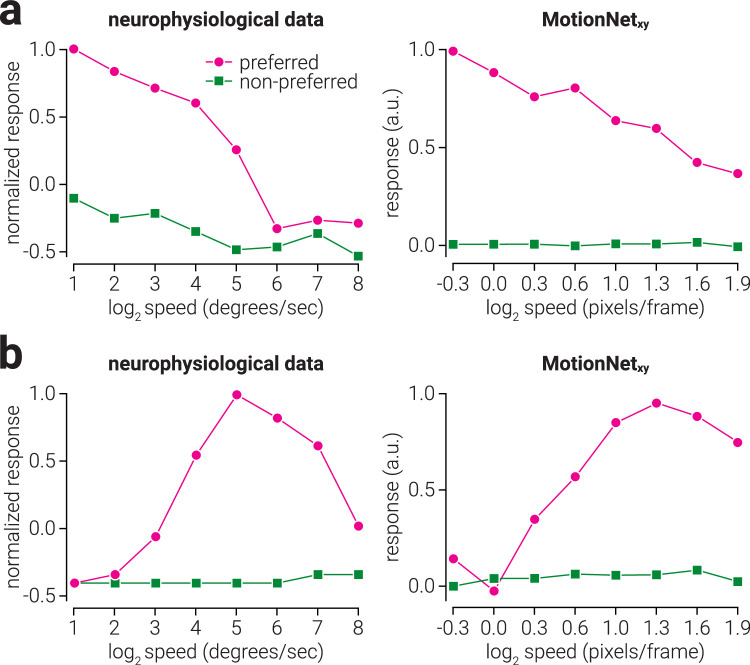
Biological and artificial visual system mechanisms of speed opponency. (a, b, left) Replotted data from Mikami, Newsome, and Wurtz (1986) showing the response of two MT neurons to a dot moving either in its preferred or non-preferred direction over a range of speeds. (a, b, right) The same as (a, b, left), but for the responses of selected MotionNetxy MT units.